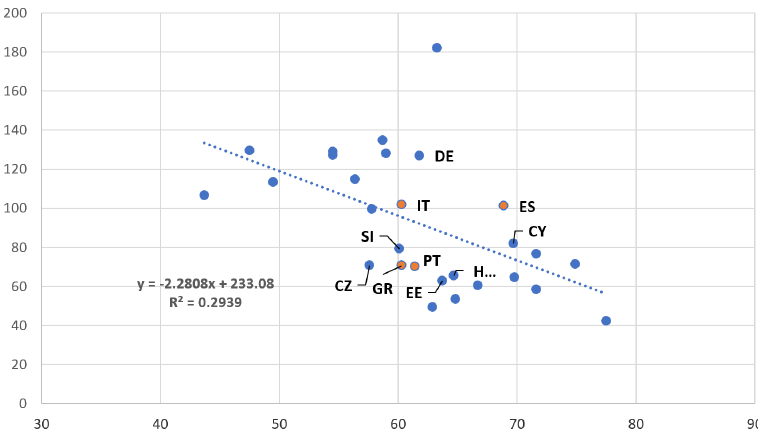
Figure 8: Relation between productivity ( y -axis) and rigid entry/exit schedule ( x -axis), 2015